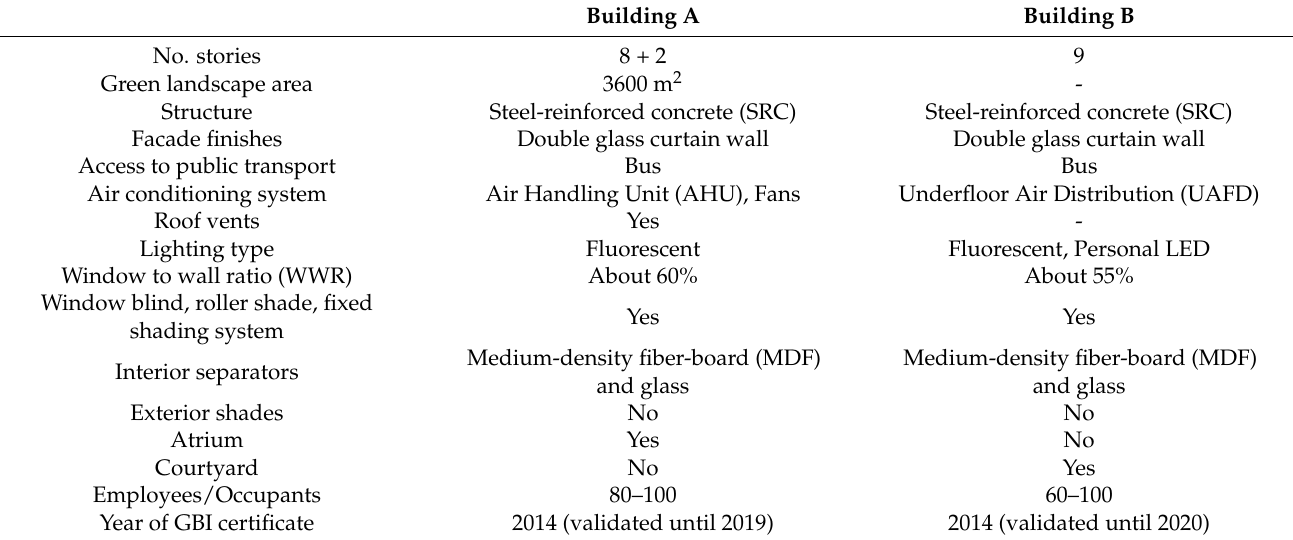
Table 1. Key data for case study buildings A and